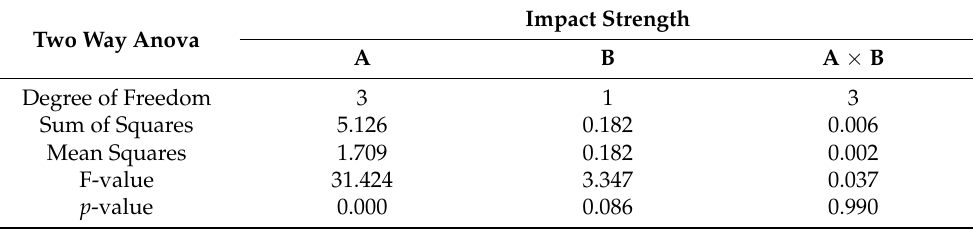
Table 7. Statistical analysis results of various 3D-printed PHB/PUA compositions on impact charac- teristics. Two Way